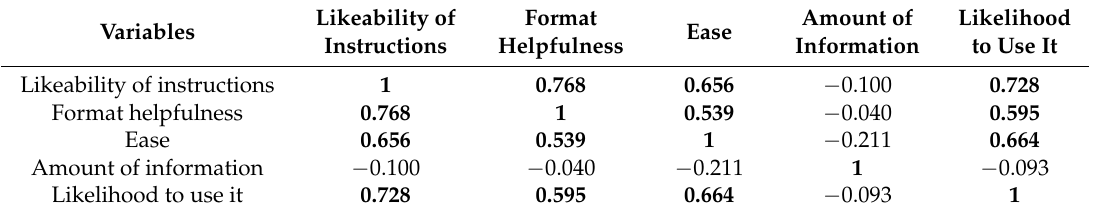
Table A2. Pearson’s correlation matrix for corn recipes’ validation ( n = 300).